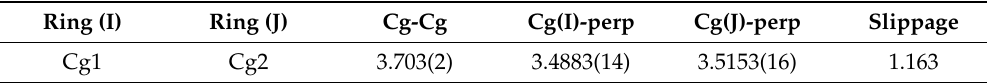
Figure 11. View of 1D supramolecular structure of the complex 2 showing the formation π ··· π stacking interaction. Table 7. Putative π - π stacking interactions [Å] for complex 2 .